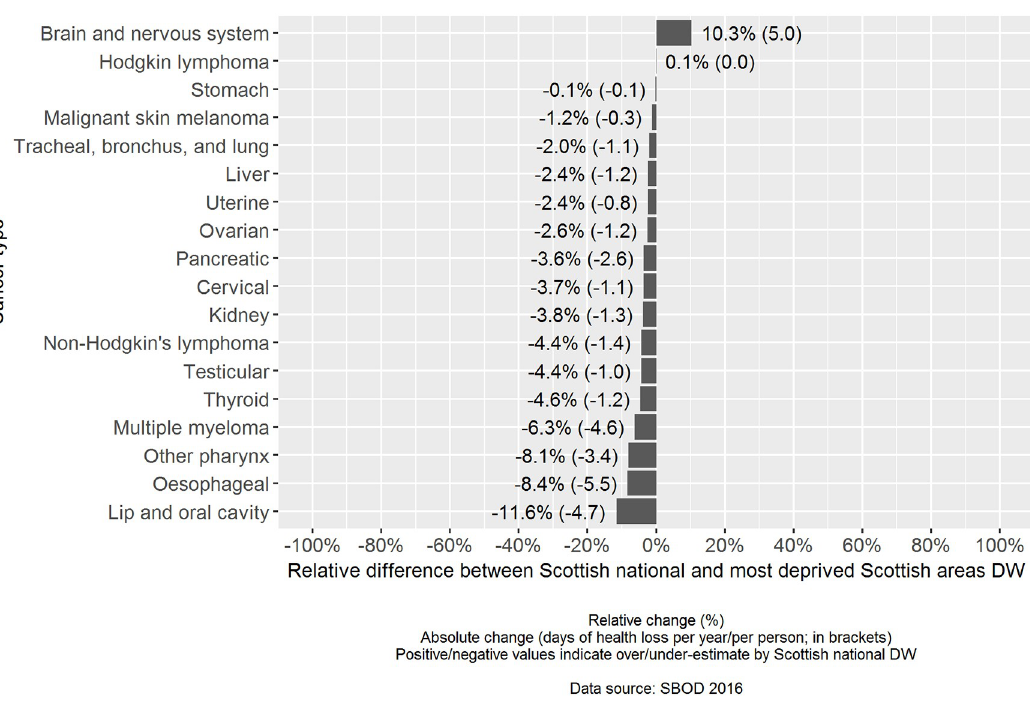
PLOS ONE | https://doi.org/10.1371/journal.pone.0221026 August 9,